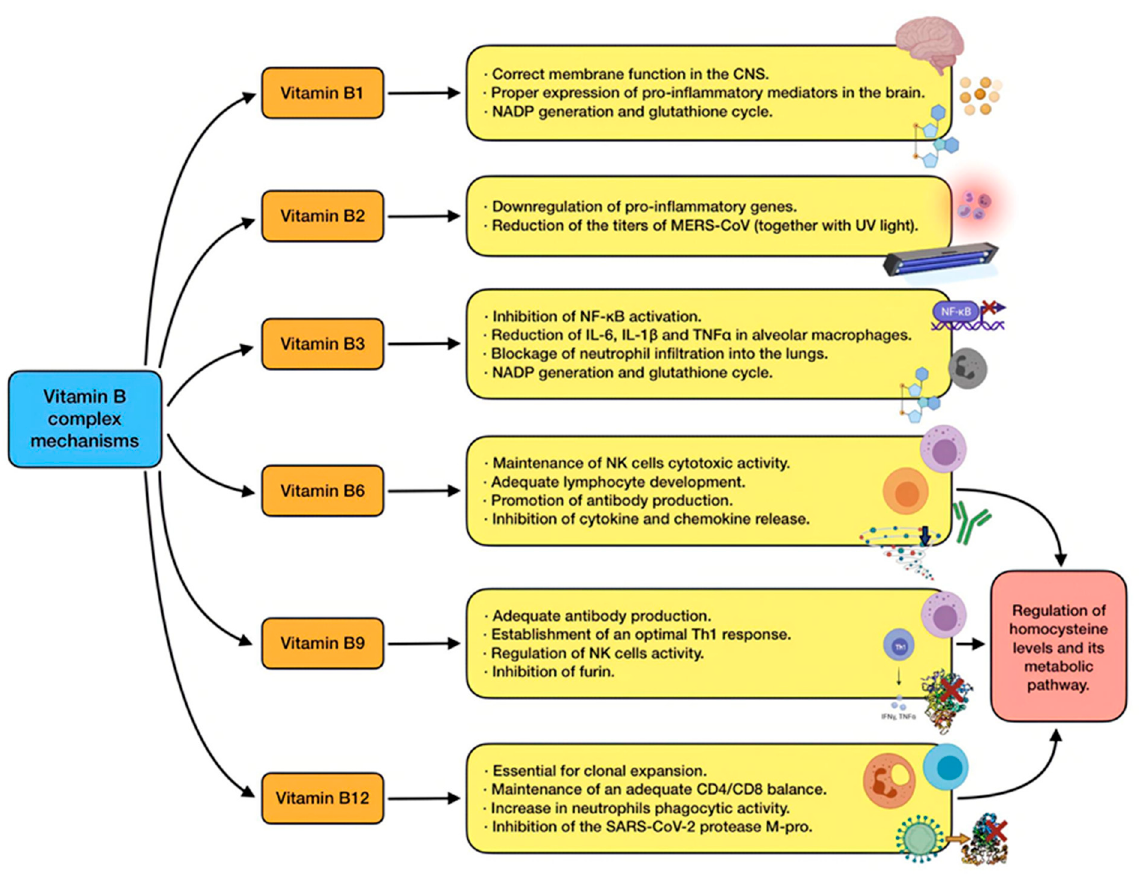
Figure 6. Summary of the main vitamin E mechanisms of